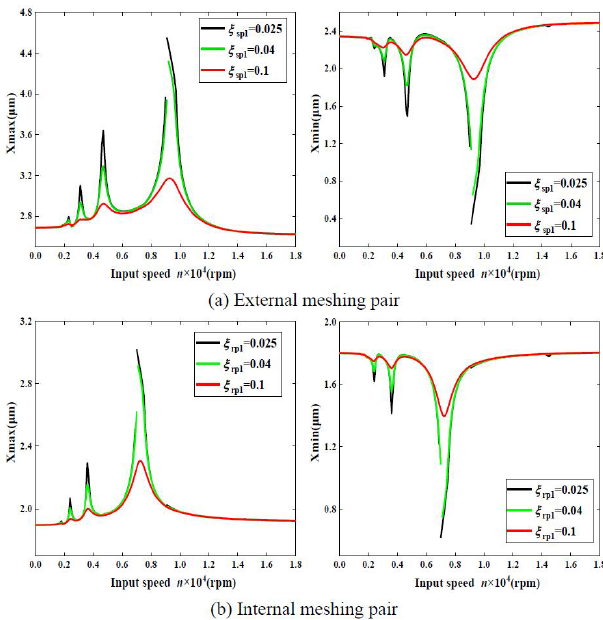
Figure 5. Vibration response curve of the planetary gear system.